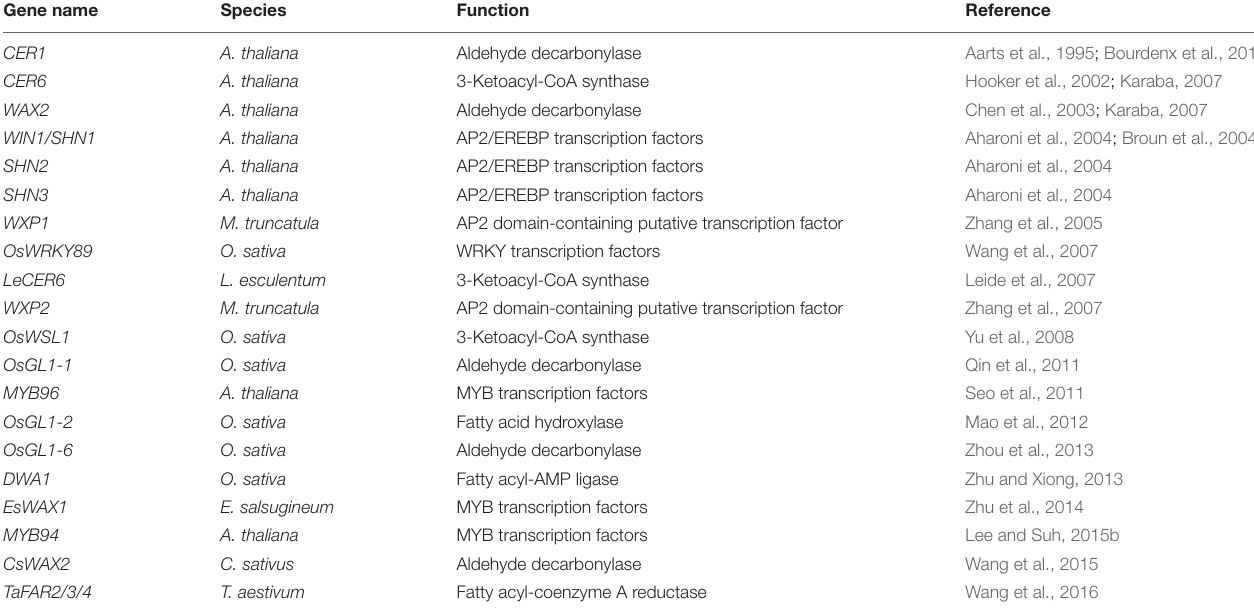
TABLE 1 | Genes known to be involved in cuticular wax response to drought